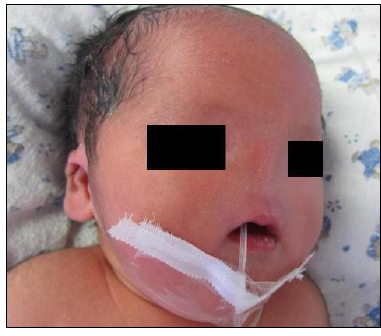
Figure 1: Clinical photograph A healthy 40-year-old, gravida 5 and para 5, woman delivered a male infant weighing 2.89 kg by spontaneous vaginal delivery at term.